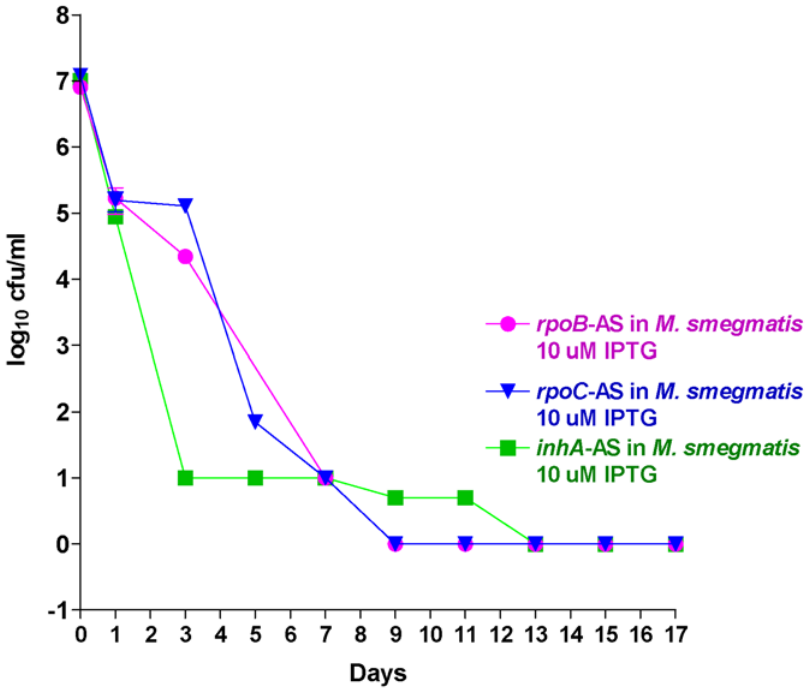
Figure 9. Survival kinetics of M.smegmatis (with M.tuberculosisinh A-AS plasmids individually). Induction at 10 uM IPTG concentration. Inh A-AS shows . 3 log10 (bactericidal target) cfu reduction in M. smegmatis .